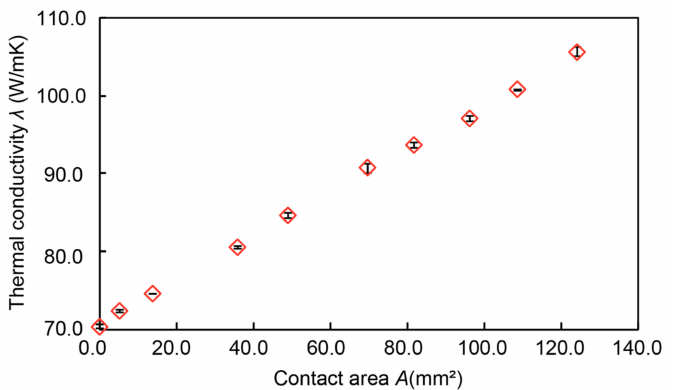
Figure 7. Measurement of thermal